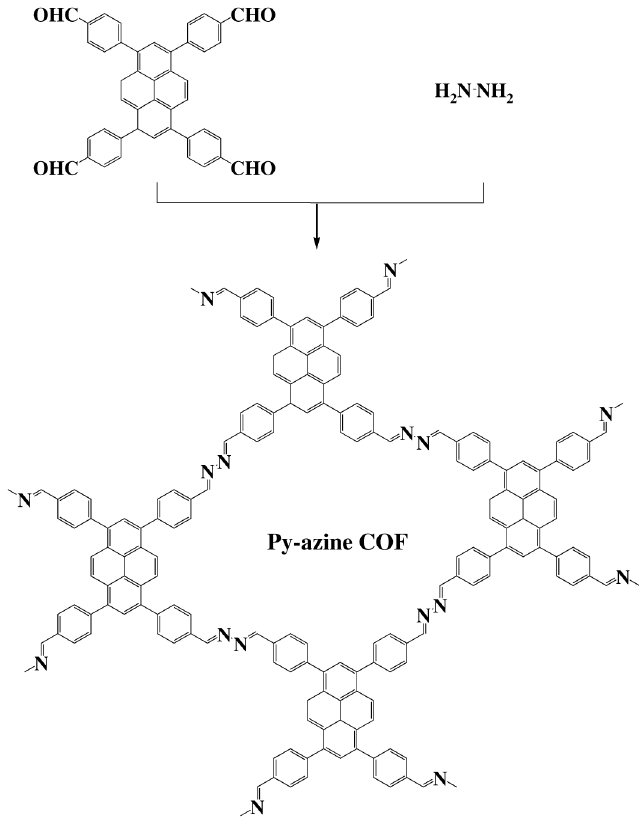
Figure 17: Synthesis and structure of Py-azine COF. Recently, a new fluorescent polyimide covalent organic framework (PI-COF) has been successfully synthe- sized by condensation of TAP-CuP and perylenetracarboxylic dianhydride through the solvothermal method (Figure 18) by Xian and co-workers (Zhang et al. 2017a). The PI-COF has been successfully utilized as an efficient fluorescent probe for the highly sensitive and selective detection of PA. The PI-COF emitted the fluorescence at 500 nm under excitation at 375 nm. The fluorescence intensity of the PI-COF was gradually reduced with the increasing concentration of PA (0 – 21 μ M). The result of the experiment exhibited a good linear response toward PA over the range from 0.5 to 10 μ M with a detection limit of 0.25 μ M. The fluorescence was mainly attributed to the existence of a p-n heterojunction between TAP-CuP and 3,4,9,10-perylenetracarboxylic dianhydride units in the PI-COF. As an electron-deficient compound with nitro groups, PA could form a PI-CONs-picrate complex through the electron transfer between protonated PI-CONs and picrate anion (PA − ), so that the fluorescence of PI-CONs was quenched by